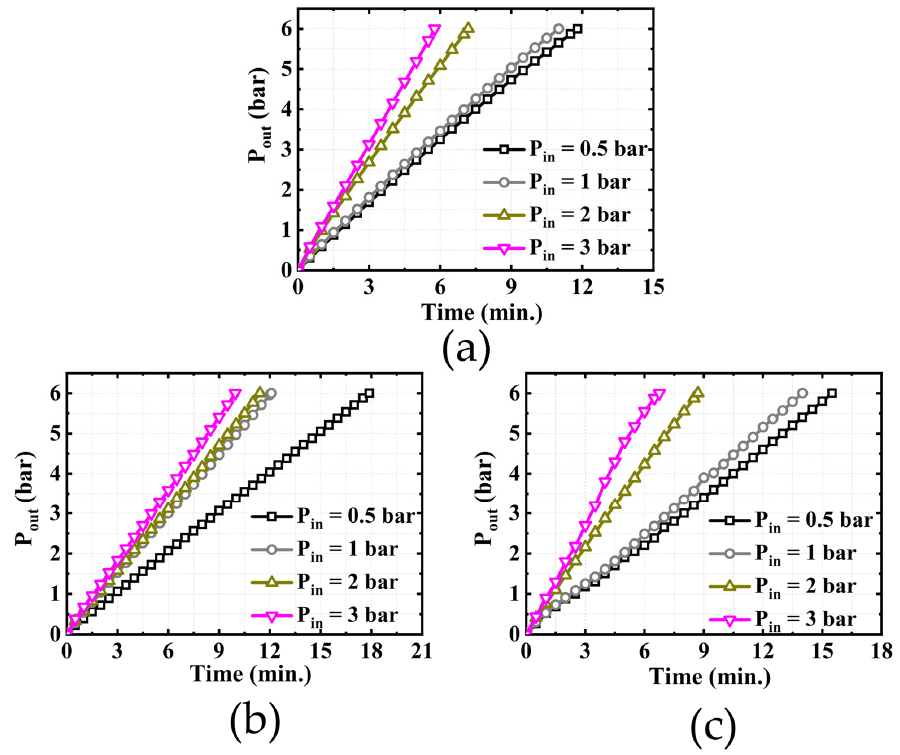
Figure 5. Variation of cathode pressure at 3 V for three experimental setups ( a ) SC-SP, ( b ) DC-SP, and ( c ) DC-DP.